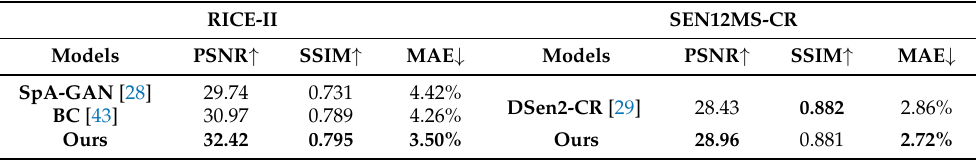
Table 6. Quantitative comparisons of cloud removal on the RICE-II and SEN12MS-CR